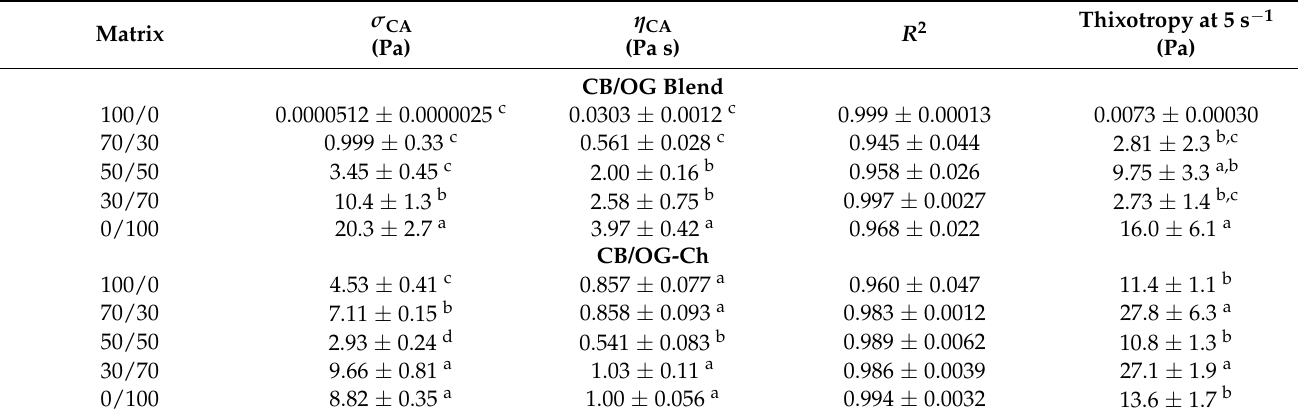
Table 5. Casson yield stress, Casson plastic viscosity and thixotropy deduced at 40 ◦ C from steady shear measurements for the different formulated CB/OG blends and CB/OG-based chocolate (CB/OG-Ch)